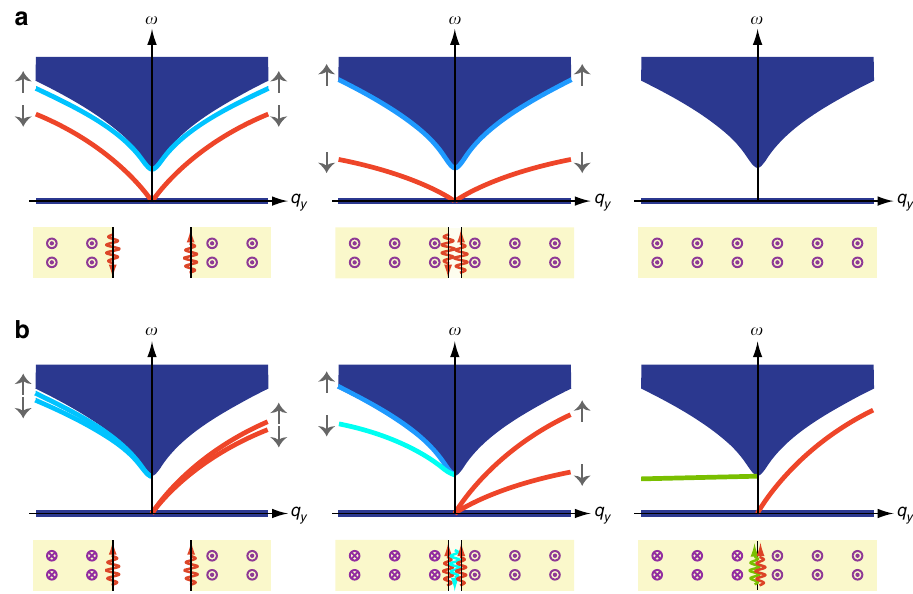
Figure 4 | Evolution of the edge states when two pieces of 2DEG are brought into contact with each other. The density spacer is gradually filled to the bulk value as the distance shrinks to zero. ( a ) The magnetic field is uniformly applied along the positive z direction in the whole space. ( b ) The magnetic field has opposite directions between the left part and right part of 2DEG.